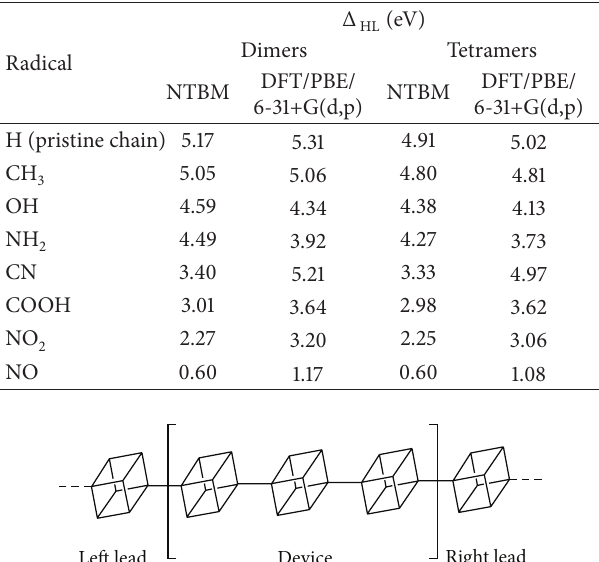
Figure 2: General scheme of the considered samples comprising three parts: semi-infinite left and right leads and device area, consisting of three substituted cubylene fragments, sandwiched between